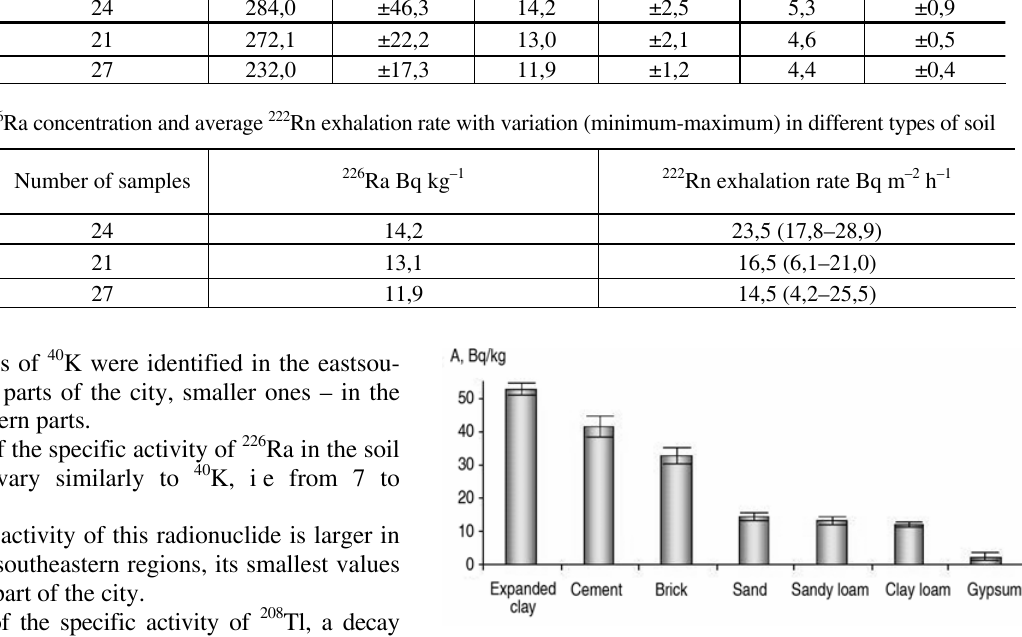
Fig 3 . Specific activity of 226 Ra in soil samples of differ- ent granulemetric composition and in building materials In Vilnius city a smaller radon exhalation rate from the soil was stated in the northern part. The biggest radon exhalation rate from the soil was stated in the southern and western parts of Vilnius city (Fig 4). Such quite a fair distribution of the values is determined by the type of the soil and its radioisotopic composition.